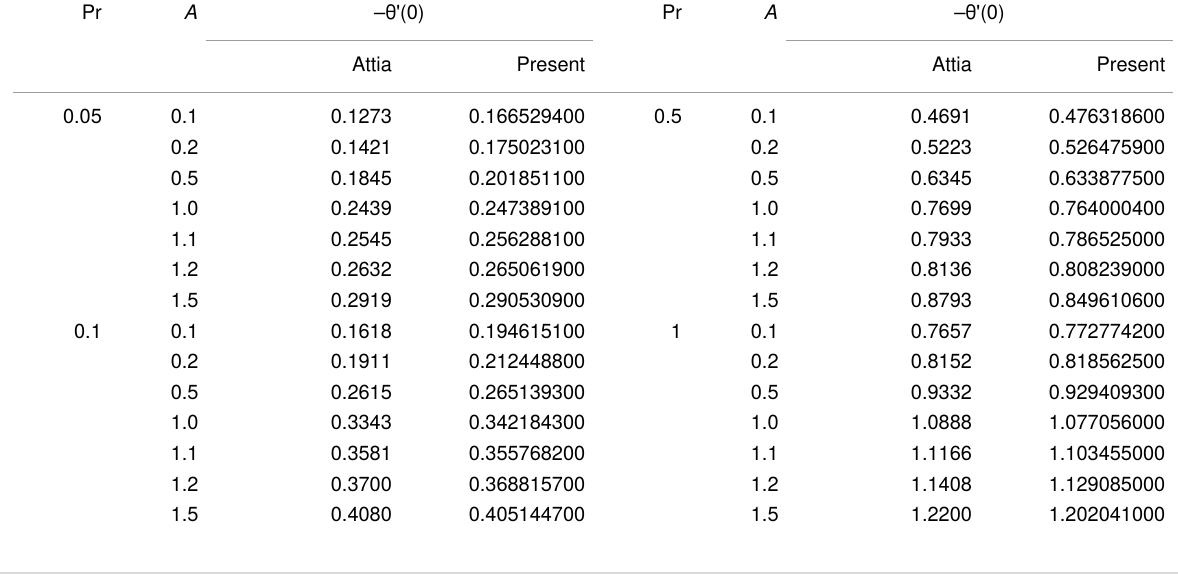
Table 2: Comparison between the computed results of Nusselt number – θ '(0) and the results given by Attia [37], when Nt = Nb = R = Ec = Sc = 0.